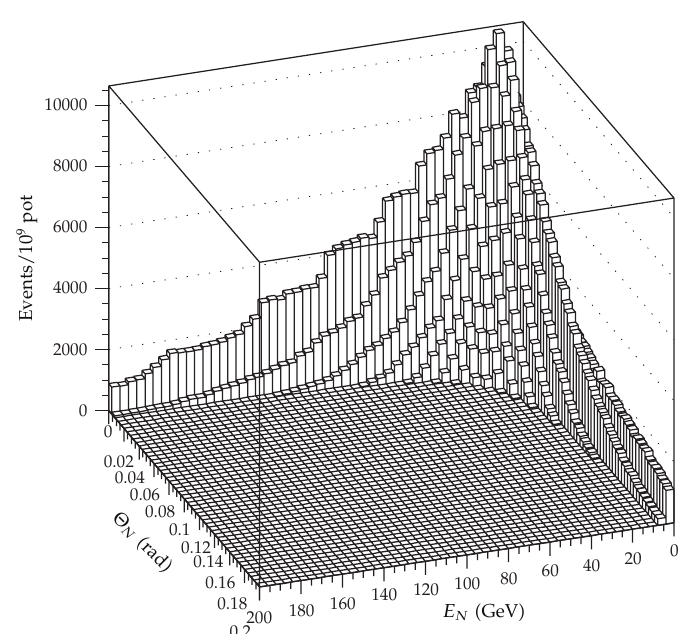
Figure 9: Two dimensional distribution of flux for 1GeV sterile neutrino as a function of Θ N , the angle between the proton beam axis and momentum of N , and its energy calculated for 400GeV proton incident on Be target. The N ’s are produced through the decay D s → μN assuming mixing strength | U μN | 2 (cid:7) 1.